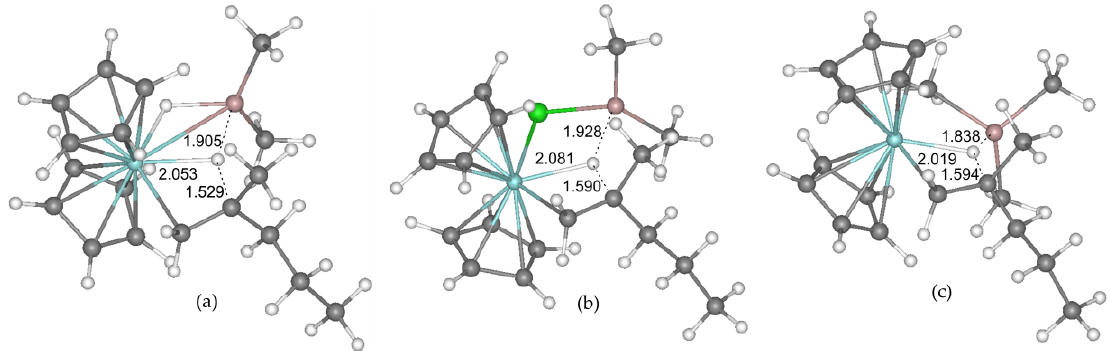
Figure 2. Calculated geometries of the transition states TS-4X (R = Me): ( a ) X = H; ( b ) X = F; ( c ) X = Cl; ( d ) X = Me. The distances Zr-H, Al–H and β C-H are specified (Å).